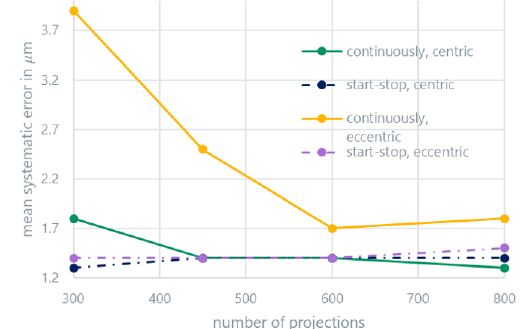
Figure 7. Random measurement error in roundness